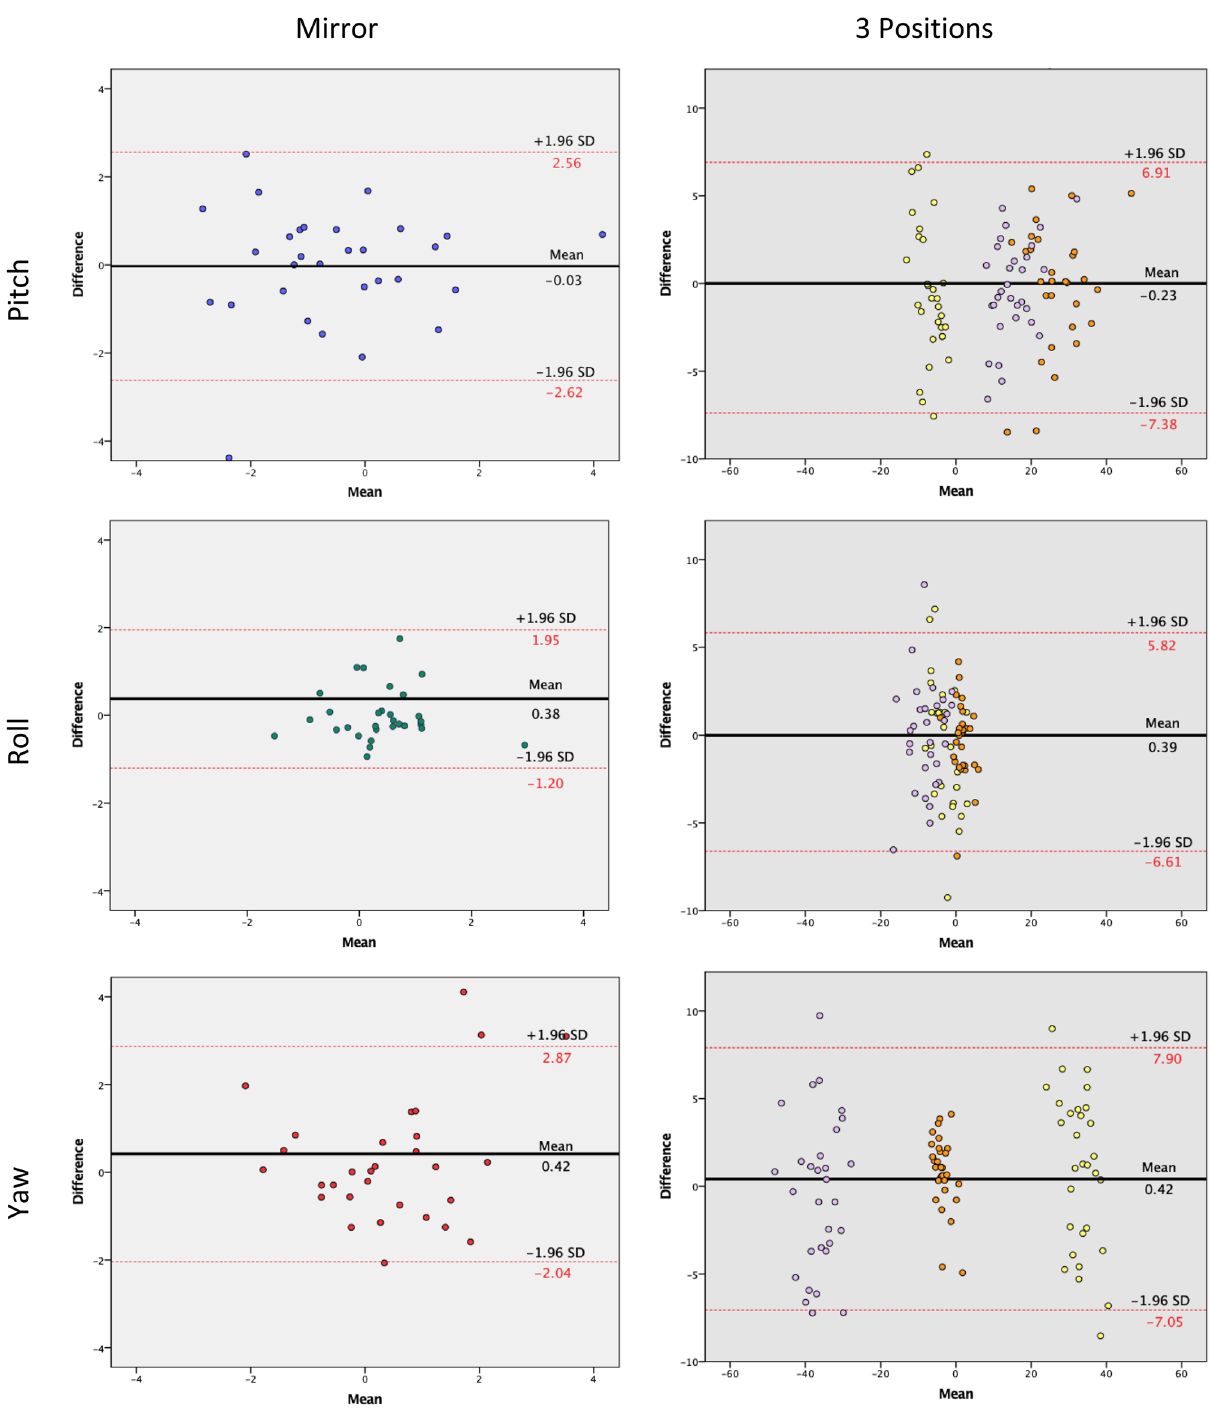
Figure 5. Bland–Altman plot between the two session: for mirror and the three positions. Bland–Altman plots show the mean differences in the measurement of the natural head position using the mirror (left column) and the 3 hunter positions (right column) from the 30 participants. Red lines indicate the 95% confidence intervals while black line indicate mean of the differences. For the 3 positions, yellow points indicate the first position, orange points the second position and purple points the third